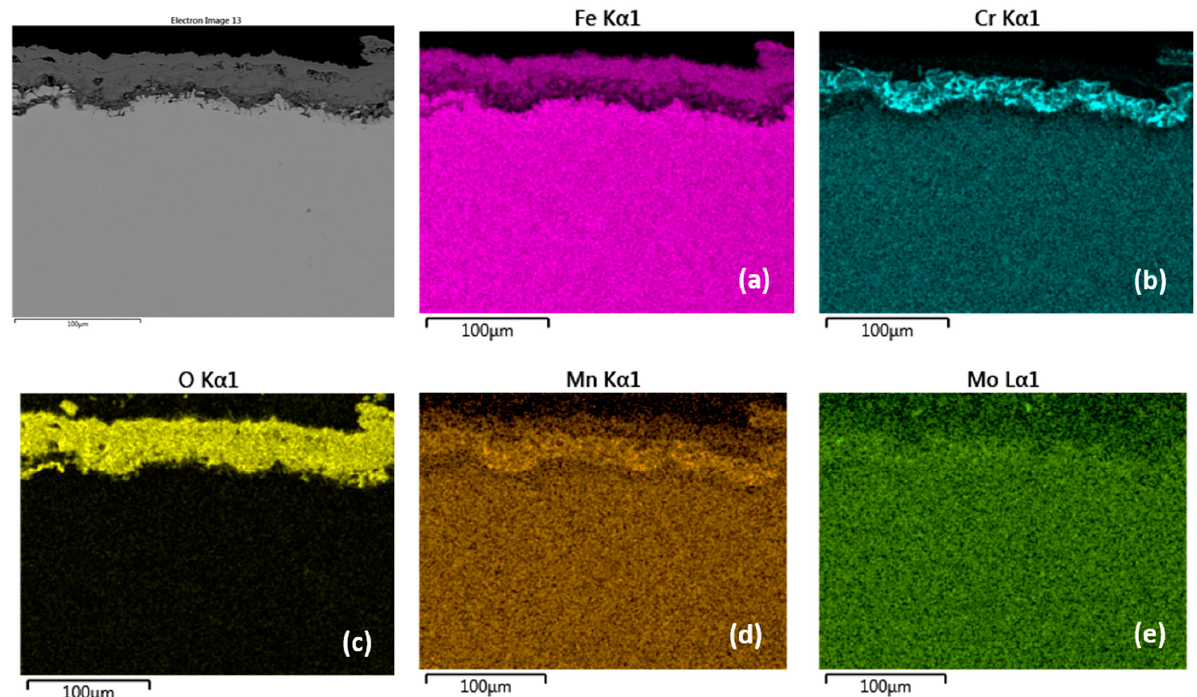
Figure 5. Cross-sectional SEM morphologies and EDS spectra analysis ( a – e ) of oxide films after oxidation for 2000 h, steel P91 at 600 °C.